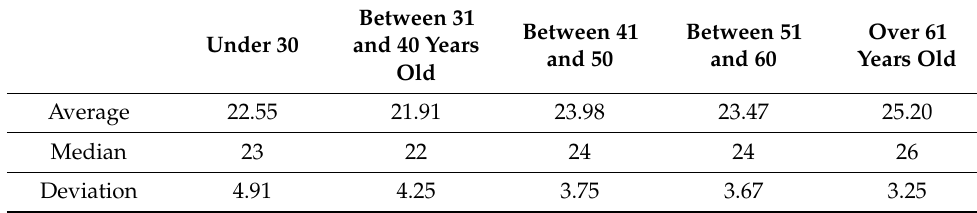
Table 3. Descriptive statistics by age group and